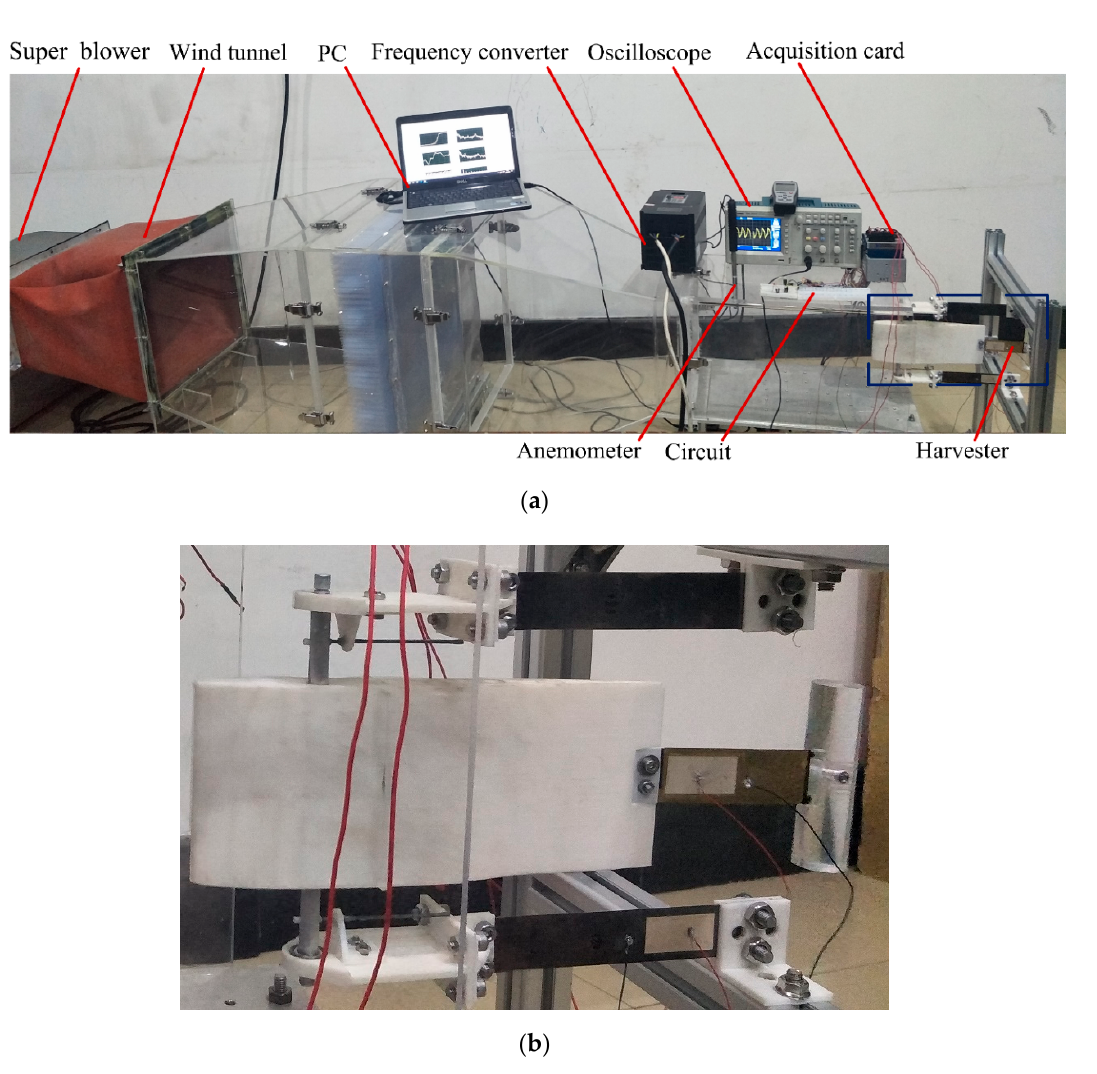
Figure 2. Experimental setup: ( a ) harvester system; and ( b ) enlarged figure of the harvester.